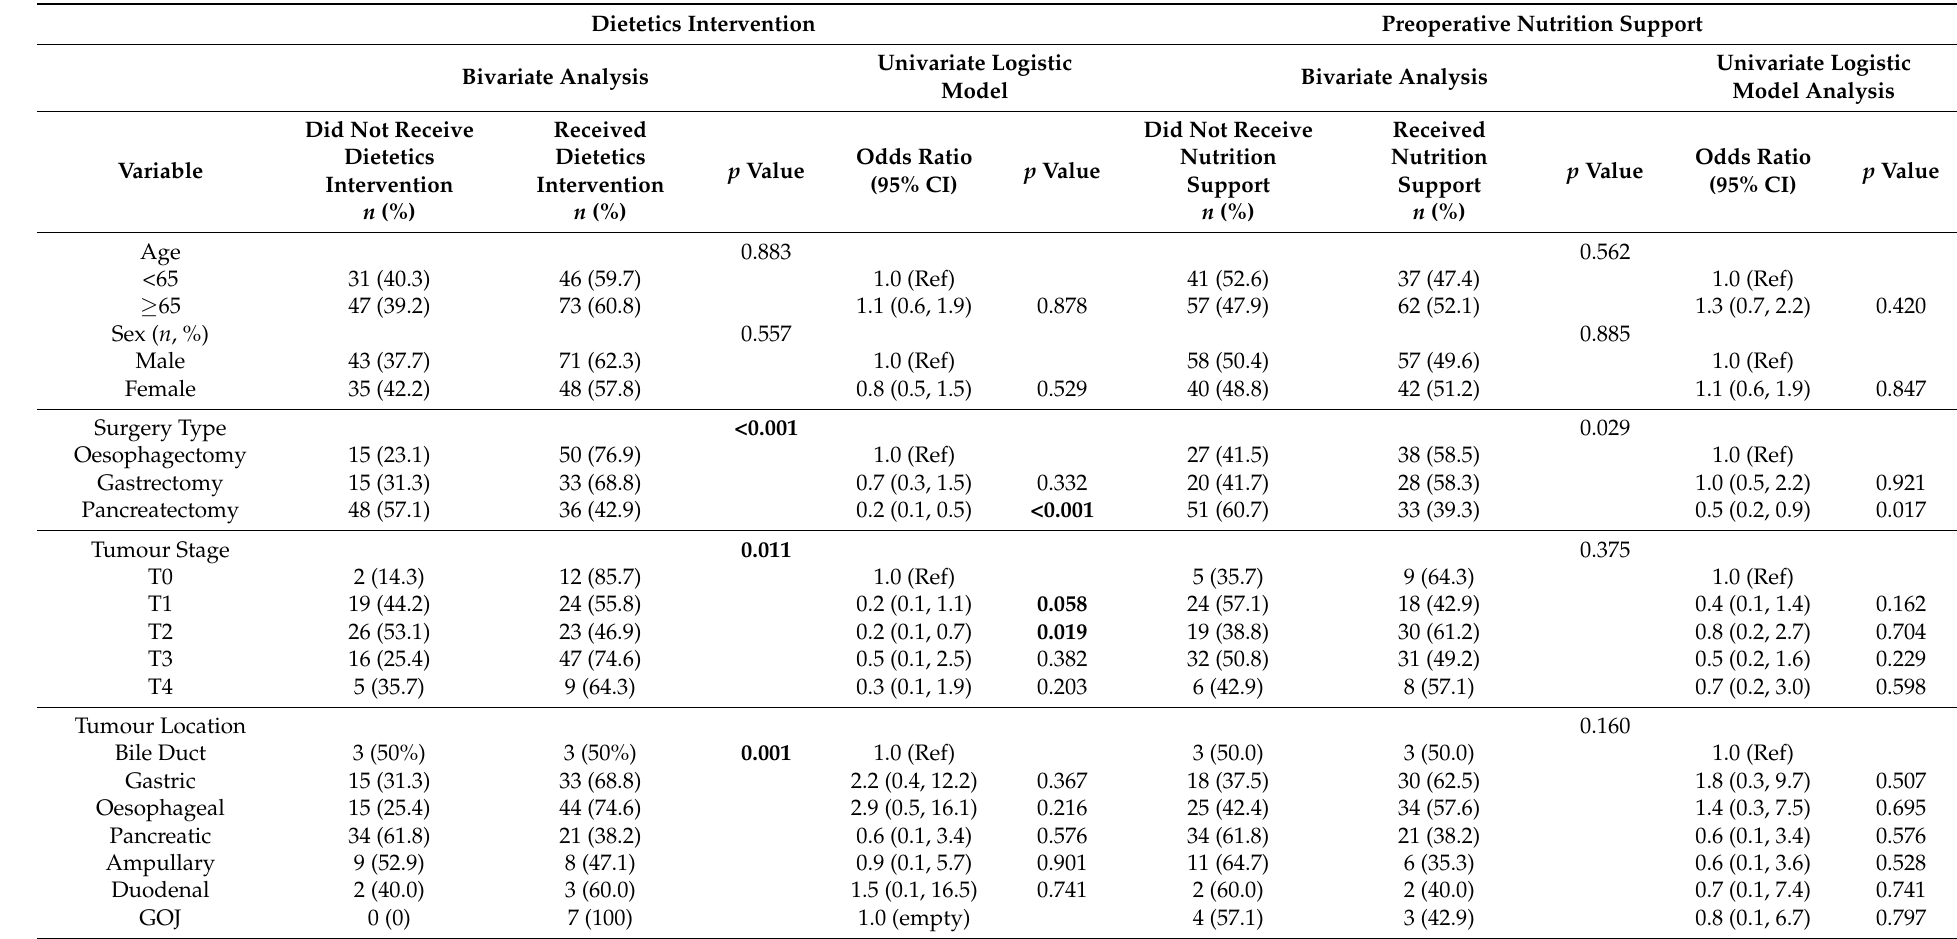
Table 3. Univariate analysis of factors associated with receiving dietetics intervention and preoperative nutrition support. Dietetics Intervention Preoperative Nutrition Support Bivariate